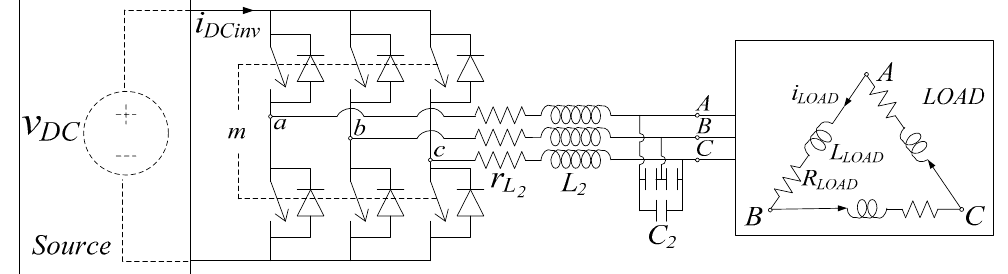
Figure 7. Grid connected inverter and AC filtering stage, basic topology.